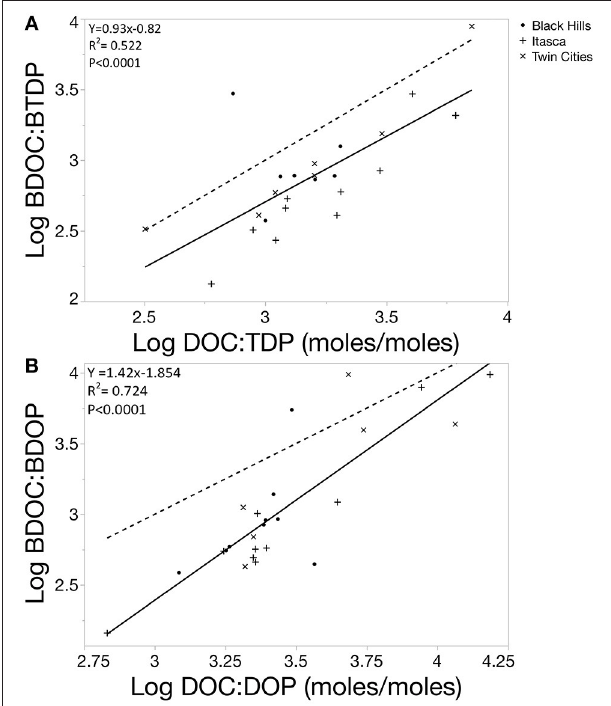
FIGURE 11 | (A) Linear regression fit (solid line) comparing the log transformed values for BDOC:BTDP ratio to the bulk DOC:TDP ratio for 24 lakes, 3 samples had to be removed from the data set because estimated BTDP was 0. Dotted line represents a 1:1 for comparison. The regression line falls below the 1:1 reference indicating that the C:P ratio of the bioavailable pool is lower than the measured C:P of the system. In other words, bulk resource ratios measured using whole water DOC:TDP would overestimate the experienced resource ratio of the microbial community (BDOC:BTDP). (B) Linear regression fit (solid line) comparing the log transformed values for BDOC:BDOP ratio to the bulk DOC:DOP ratio for 24 lakes, 3 samples had to be removed from the data set because estimated BTDP was 0. Dotted line represents a 1:1 for comparison. The regression line falls below the 1:1 reference indicating that the C:P ratio of the bioavailable pool is lower than the measured C:P of the system. Additionally, the slope of the regression fit is greater than 1 meaning that BDOC:BDOP ratios more closely match bulk DOC:DOP ratios when they are higher (in systems that are DOP poor relative to